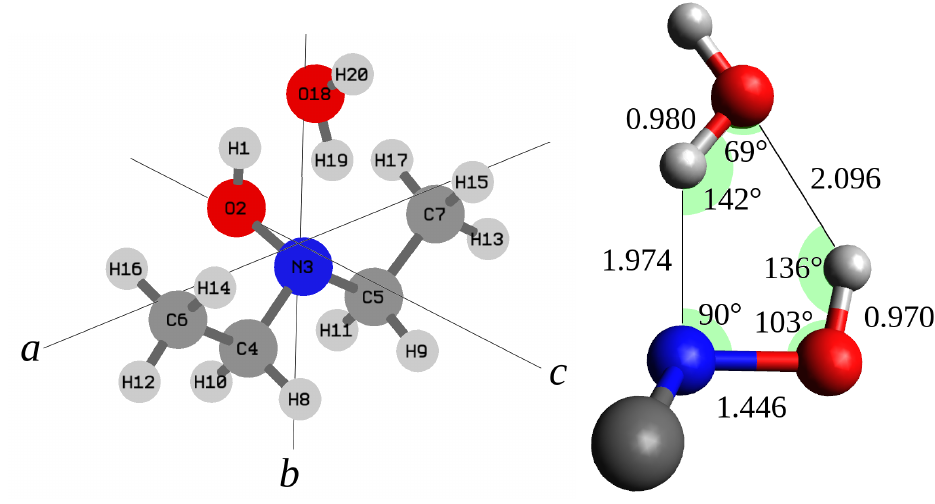
Figure 3. Left side: structure, number of the atoms, and principal inertial axis system of DEHA-W. Right side: r 0 bond distances (Å) and